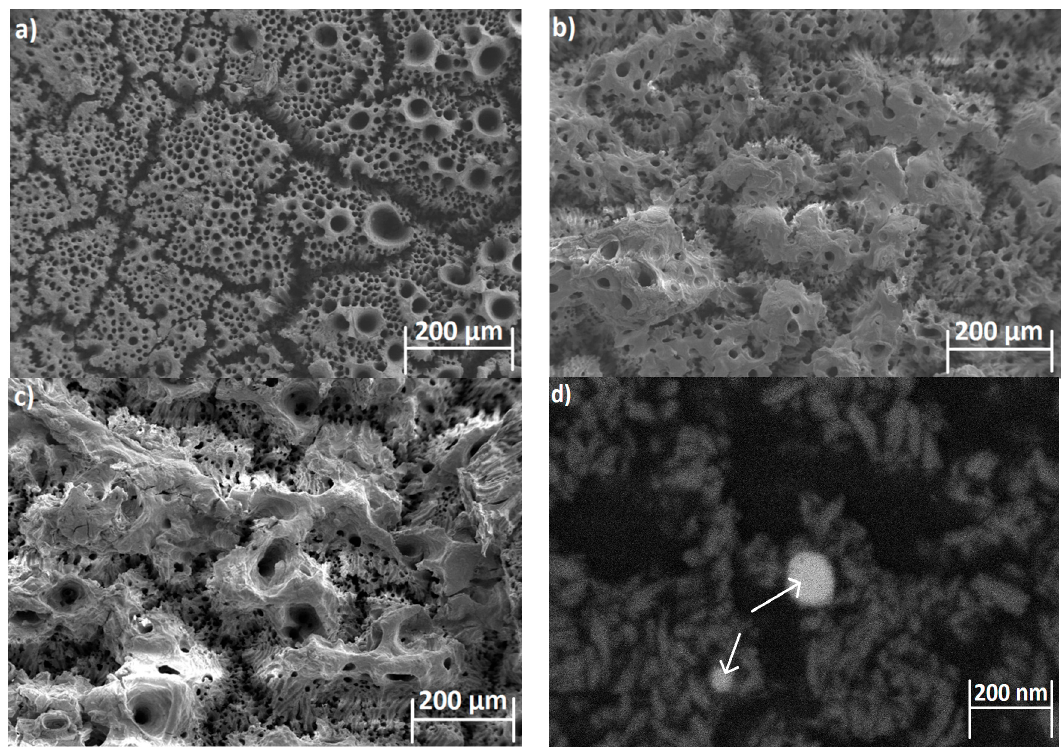
Figure 3. HRSEM images of the HA film with Re:IF-MoS 2 obtained from solution A after 2 ( a ), 3 ( b ), and 4 h ( c ) deposition. The Re:IF-MoS 2 nanoparticles in the film ( c ) are observed in the backscattering electron (BSE) mode ( d ). The arrows in Figure 3d point on the Re:IF-MoS 2 nanoparticles occluded in the HA film.